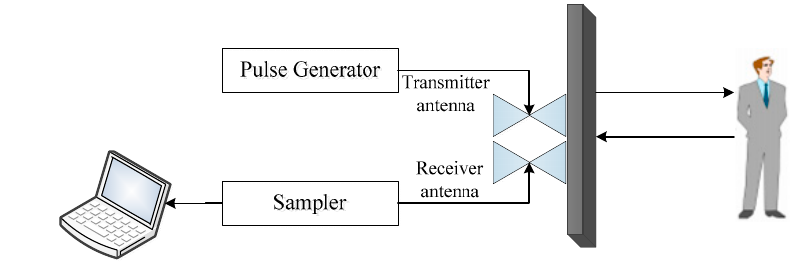
Figure 1. The experimental setups for human being detection.